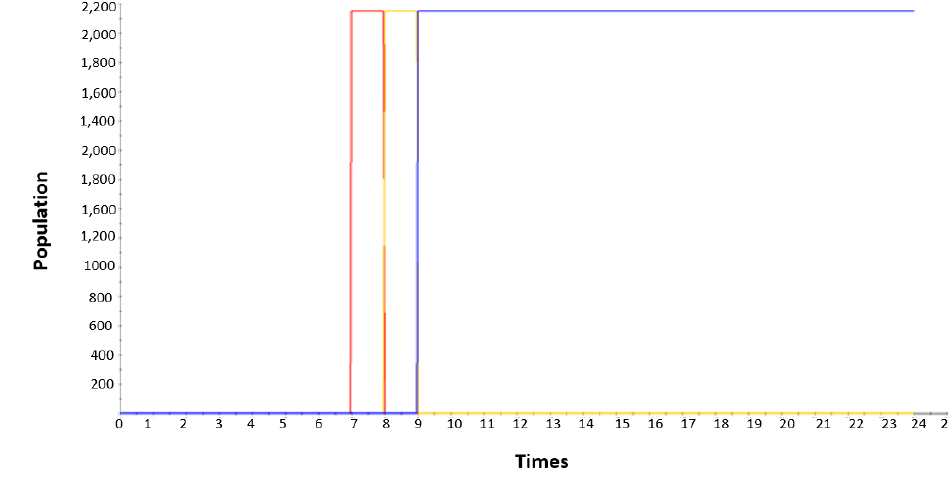
Figure 9. Estimated infection, disease, and fatalities (contaminant at the isolated